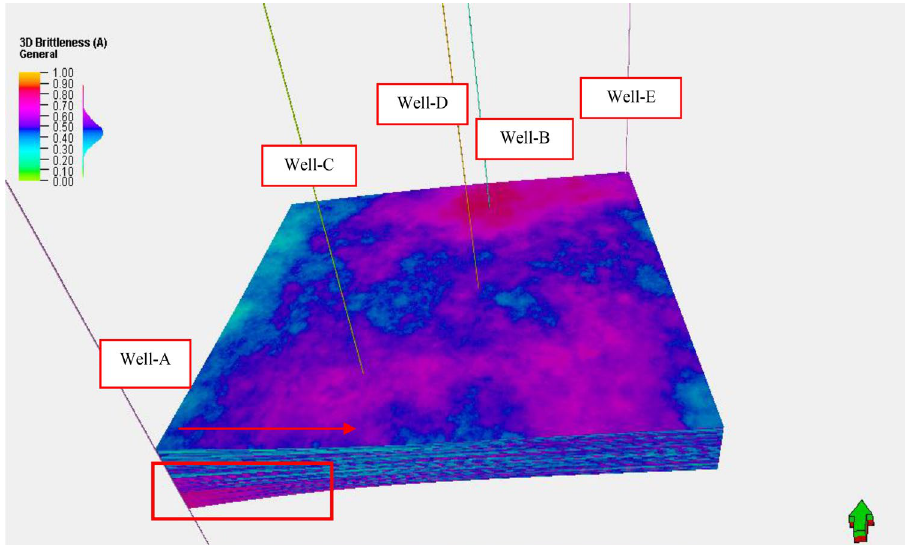
Fig. 20 3D brittleness model of the studied